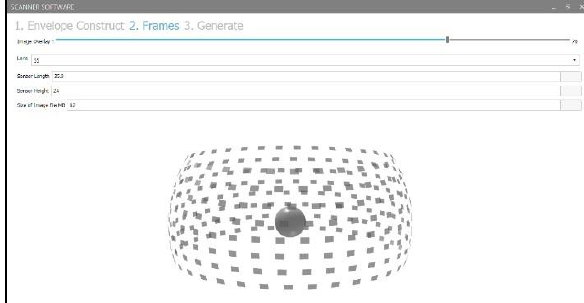
Figure 4. Generation of camera positions in